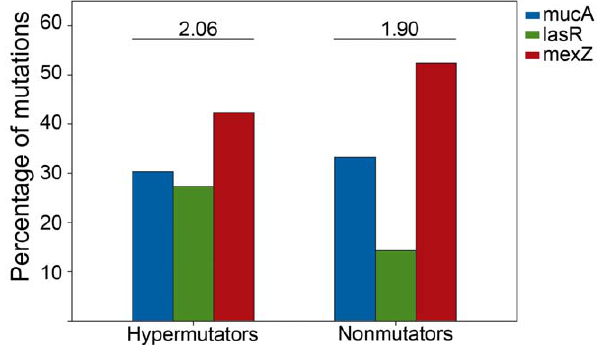
Figure 2. Distribution of the number of mutations among mucA , lasR and mexZ genes in hypermutator and nonmutator isolates. The number of mutations occurring in mucA (blue bars), lasR (green bars) and mexZ (red bars) is expressed as a percentage respect to the total number of mutations found in hypermutator and nonmutator isolates. Above the bars, the total number of mutations per isolate for the hypermutator and nonmutator subpopulations is indicated.